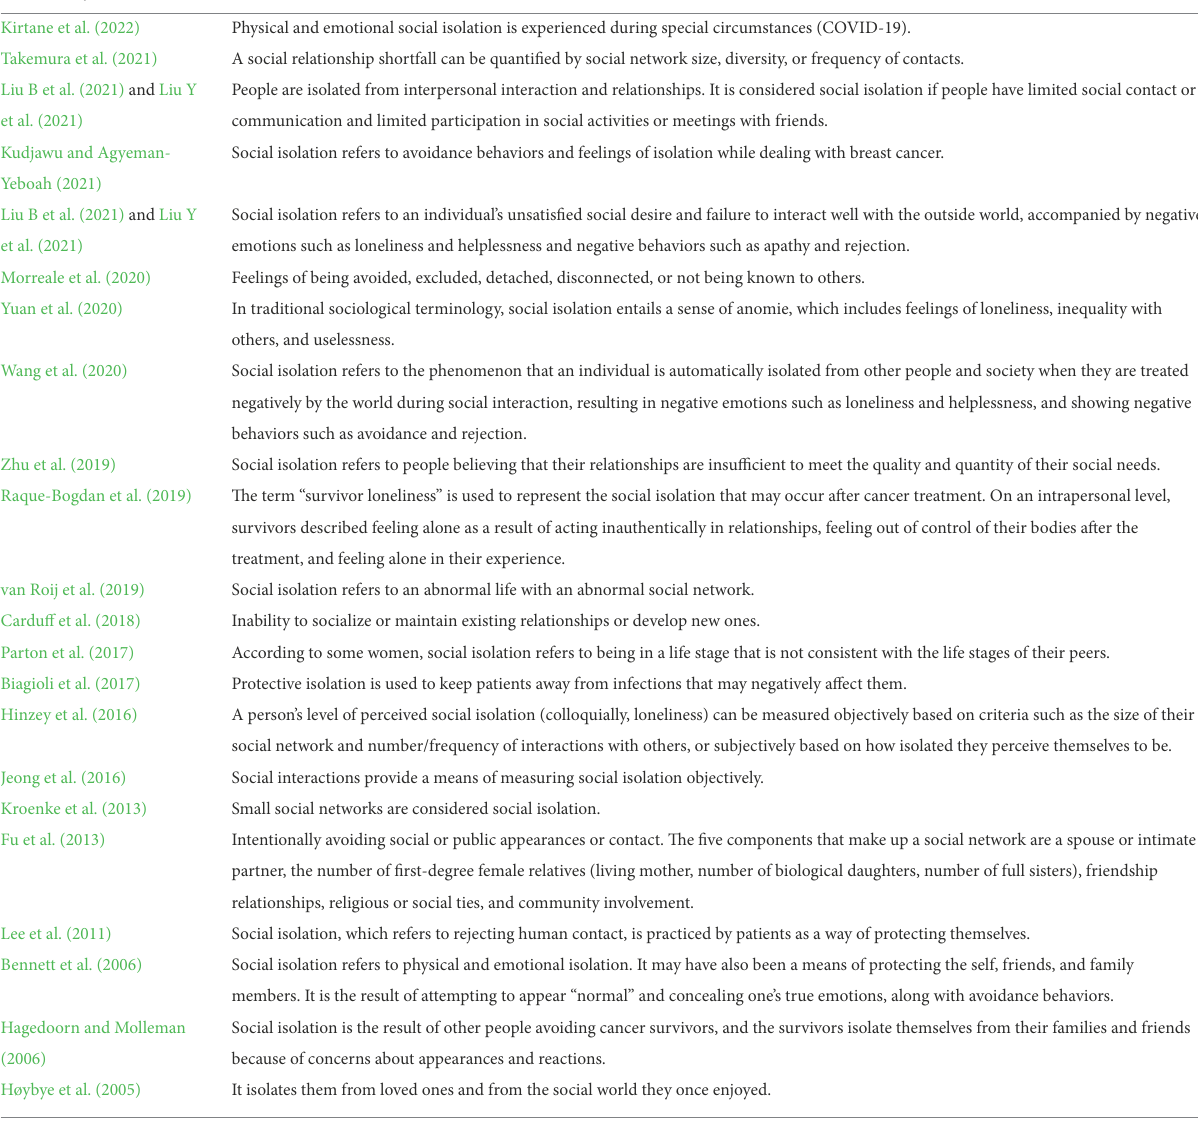
TABLE 2 Samples of social isolation definitions applied in studies included in the